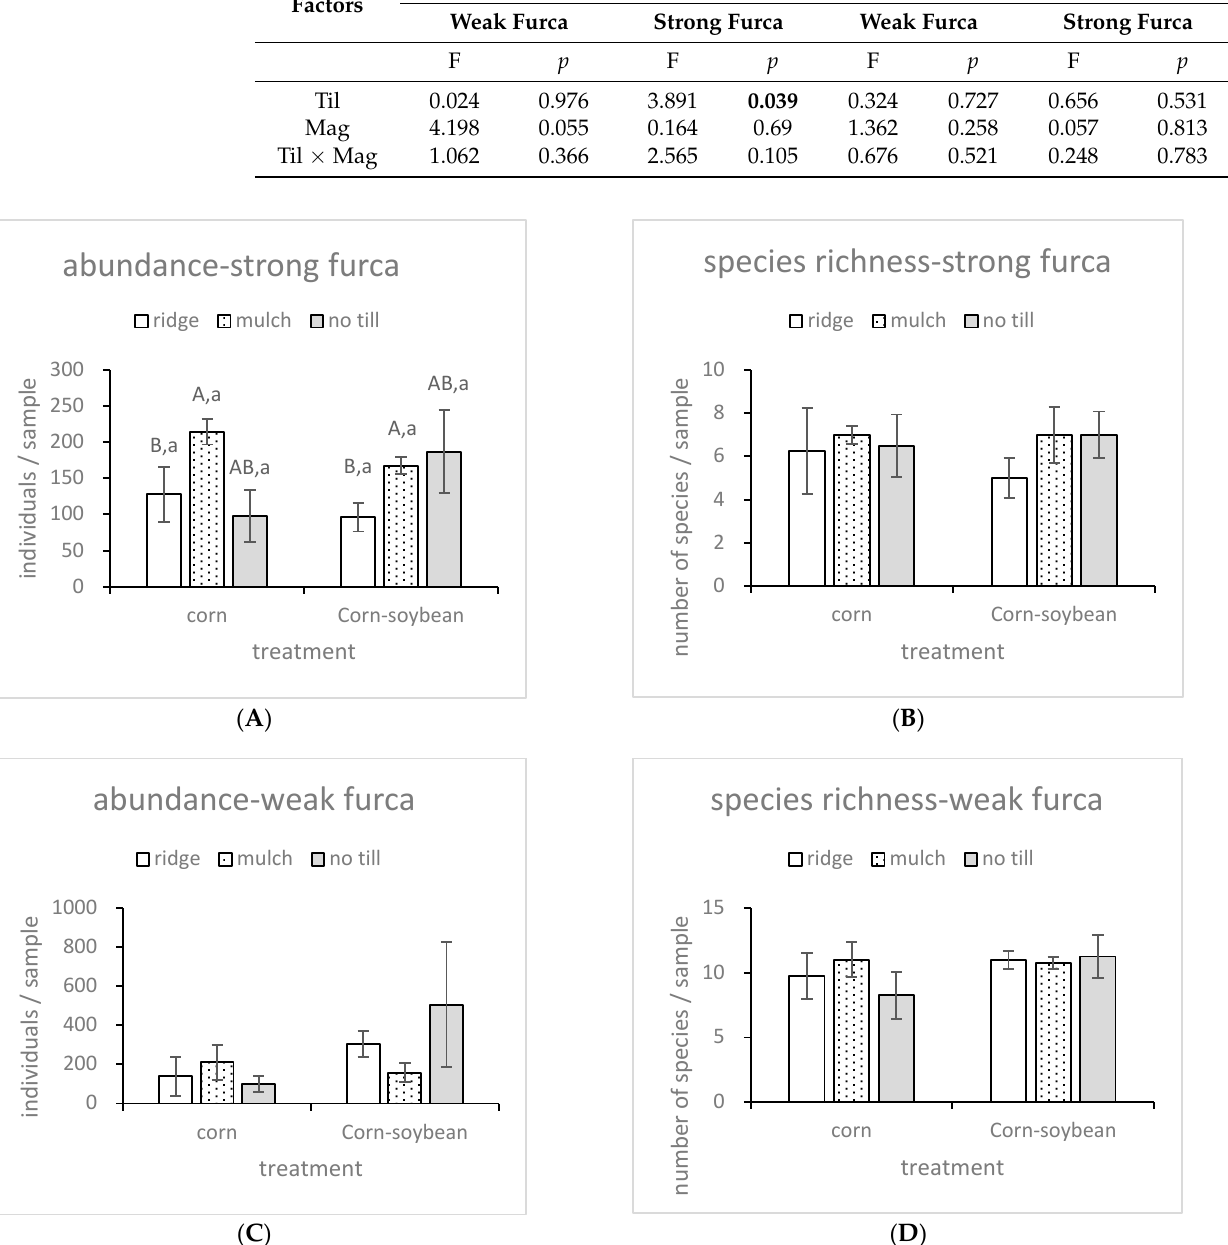
Figure 1. Analysis of variance (ANOVA) barplot of the treatments data showing ( A ) abundance of strong furca ( B ) specie richness of strong furca ( C ) abundance of weak furca ( D ) specie richness of weak furca across three tillage types are differentiated by capitalized letters (A, B, AB) and across corn, and corn–soybean rotation is differentiated by lower case letters (a, b) Superscripts indicate significant differences between factors at the 0.05 level.